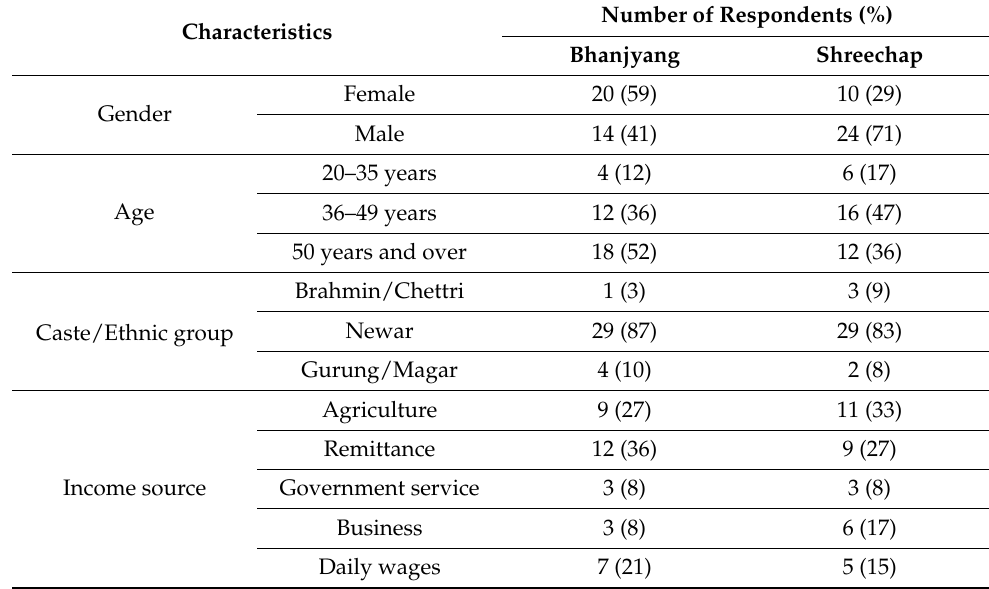
Table 2. Demographic characteristics of the